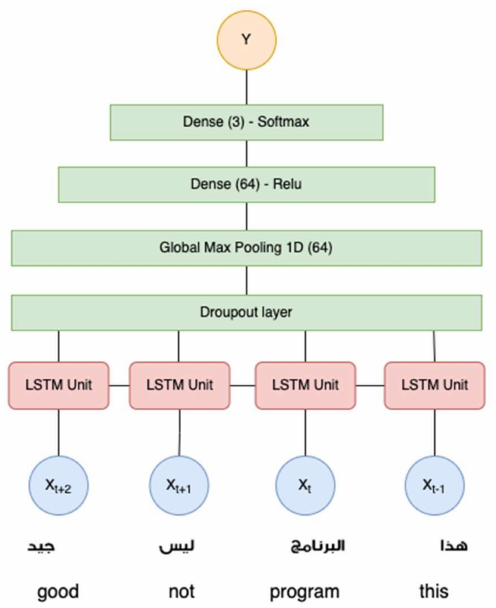
Figure 5. Single-layer LSTM architecture.